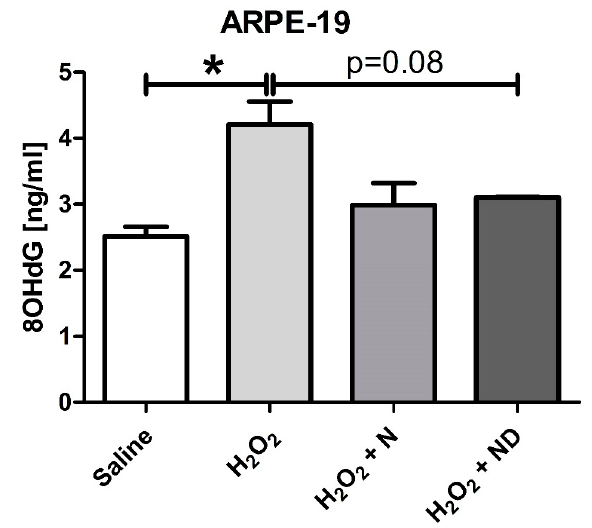
Figure 3. Oxidative damage to DNA was analyzed by 8OHdG expression levels for ARPE-19 cells measured by ELISA ( n = 3 ) . Addition of H 2 O 2 (2 h; 1000 µM) to induce oxidative stress